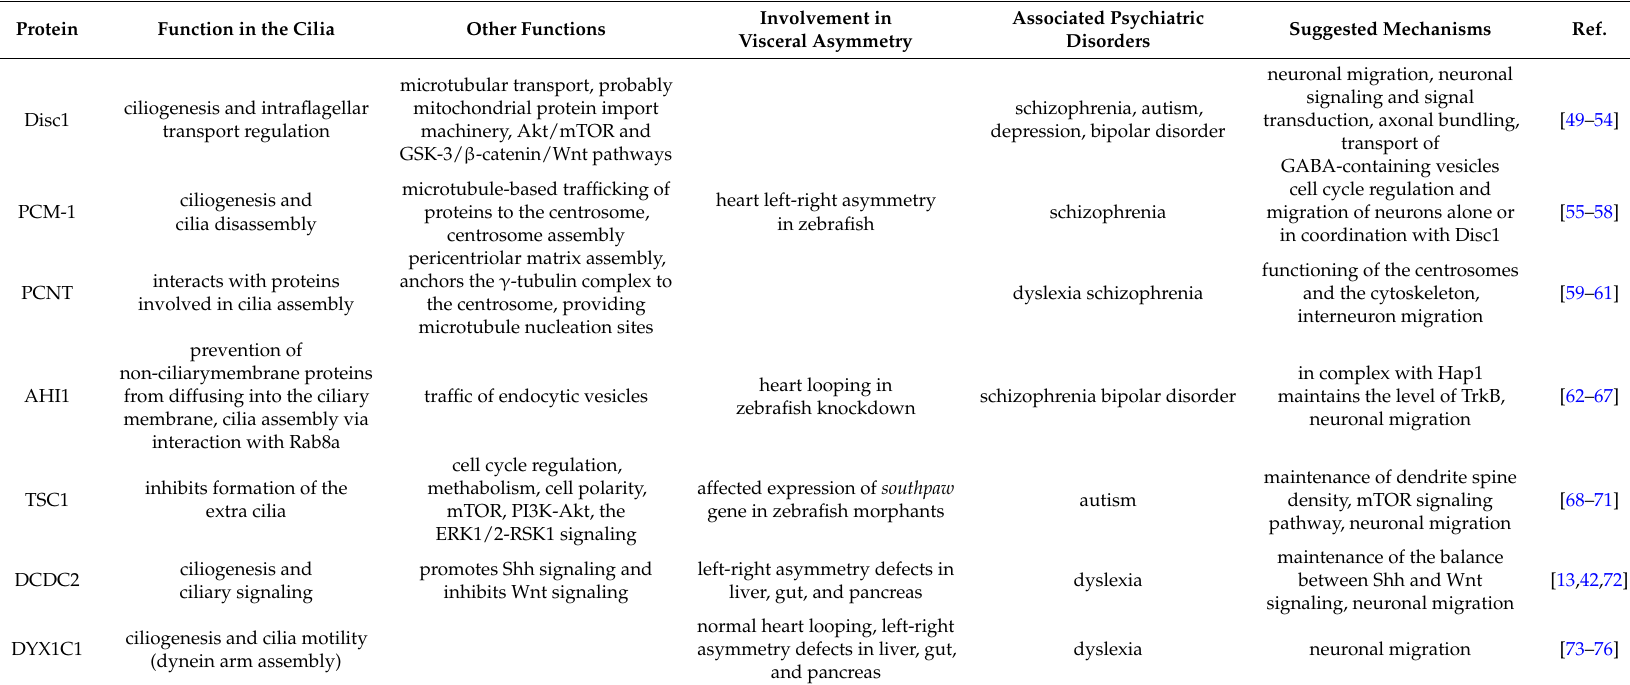
Table 1. Ciliary protein functions, involved in visceral asymmetry and neurodevelopmental